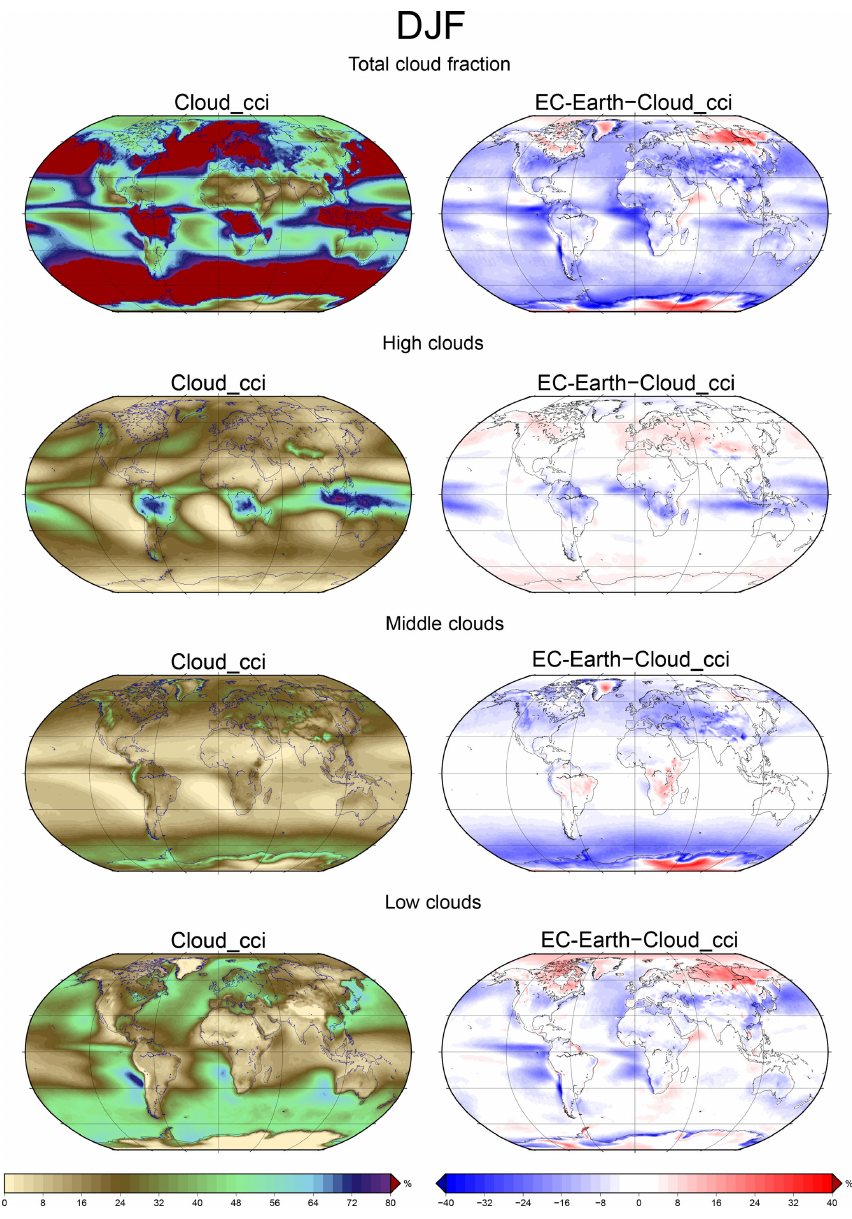
Figure 5. Same as Fig. 4 but for